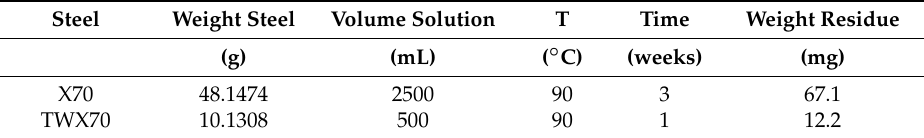
Table 2. Dissolution parameters for X70 and TWX70 steels.